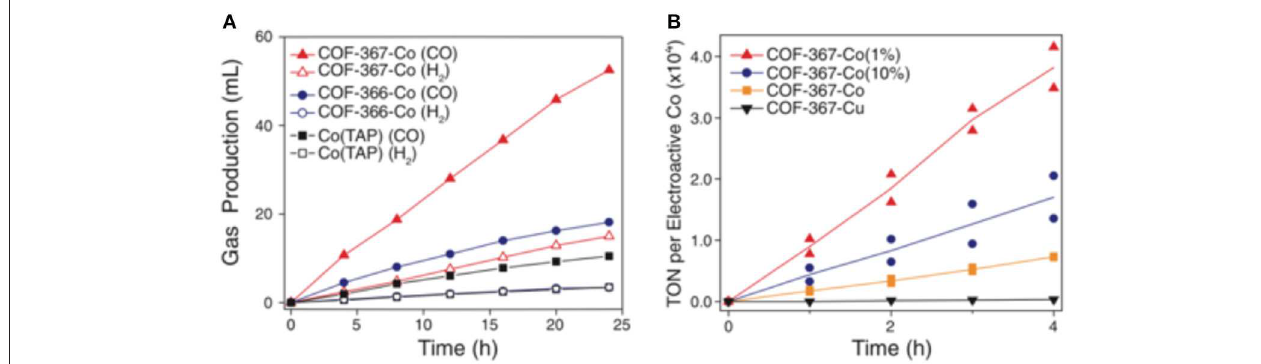
FIGURE 14 | (A) The CO production of various COFs as determined by Lin et al. (2015): (red solid triangles) COF-367-Co; (blue solid circles) COF-366-Co; (black solid squares) Co(TAP); Also shown is the volume of hydrogen produced by various COFs as determined by Lin et al. (2015): (red open triangles) COF-367-Co; (blue open circles) COF-366-Co; (black open squares) Co(TAP) and (B) TON for the CO production of various bimetallic COFs as measured by Lin et al. (2015) at − 0.67V. COF-367-Co(1%) (red solid triangles); COF-367-Co(10%) (blue solid circles); COF-367-Co (orange solid squares) and Co-367-Cu (purple solid inverted triangle; TON in this case is calculated per unit of copper porphyrin). Reprinted with permission © 2015 Science.